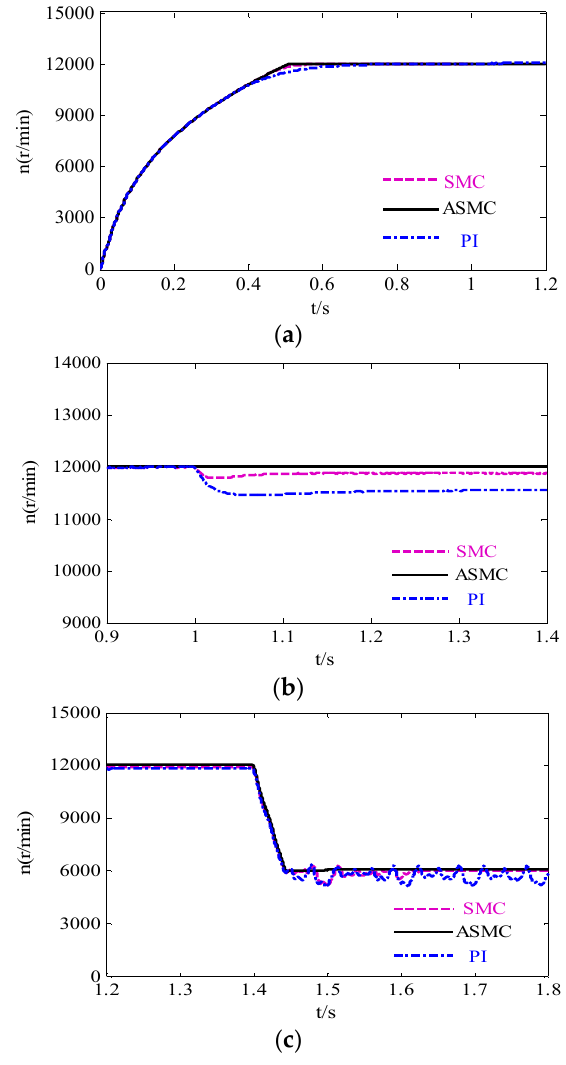
Figure 5. The simulation of system dynamic response (12,000 r/min): ( a ) the response of speed under no ‐ load; ( b ) the response of speed under the sudden load (5 N ∙ m); ( c ) the response of speed mutation under the torque disturbance (from 12,000 r/min to 6000 r/min).